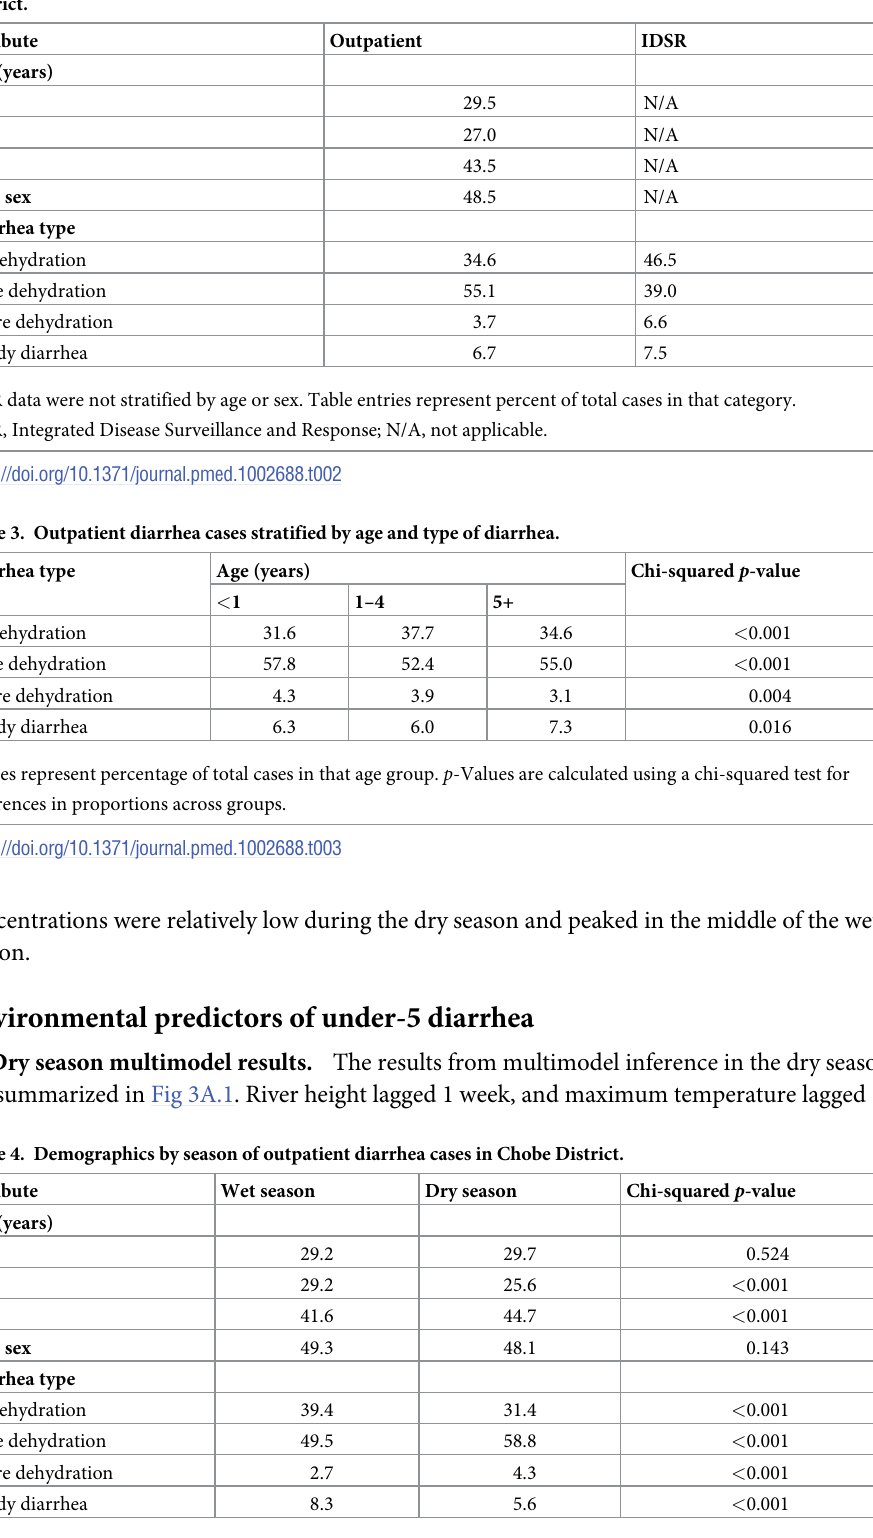
Table entries represent percent of total cases in that season. p -Values were calculated using a chi-squared test.